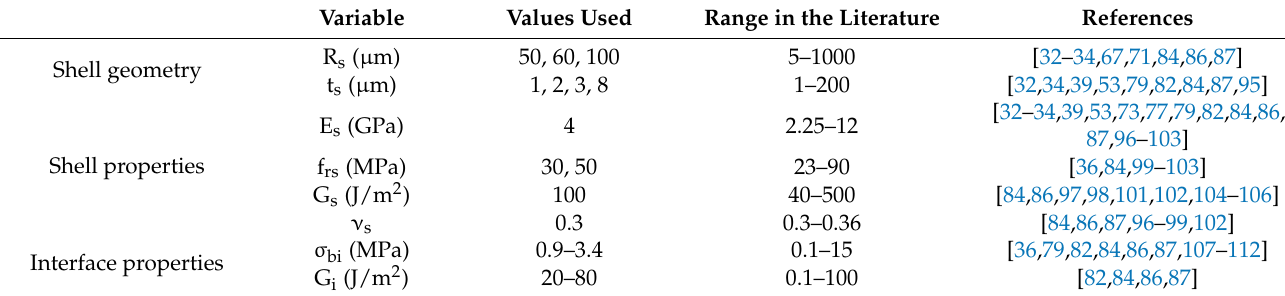
Table 5. Capsule and interface properties.